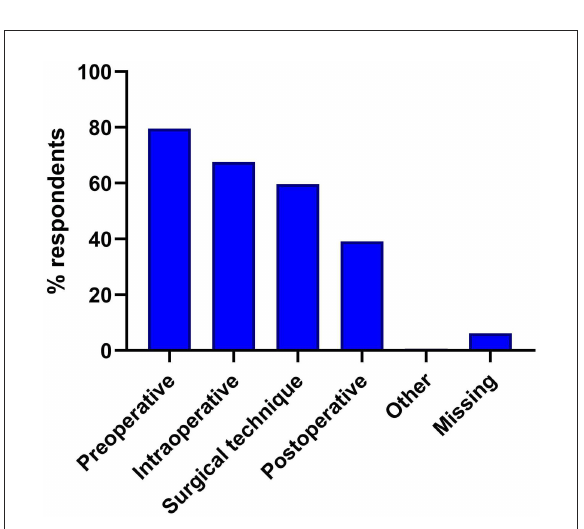
FIGURE2 Perceived uses for artificial intelligence in medicine.